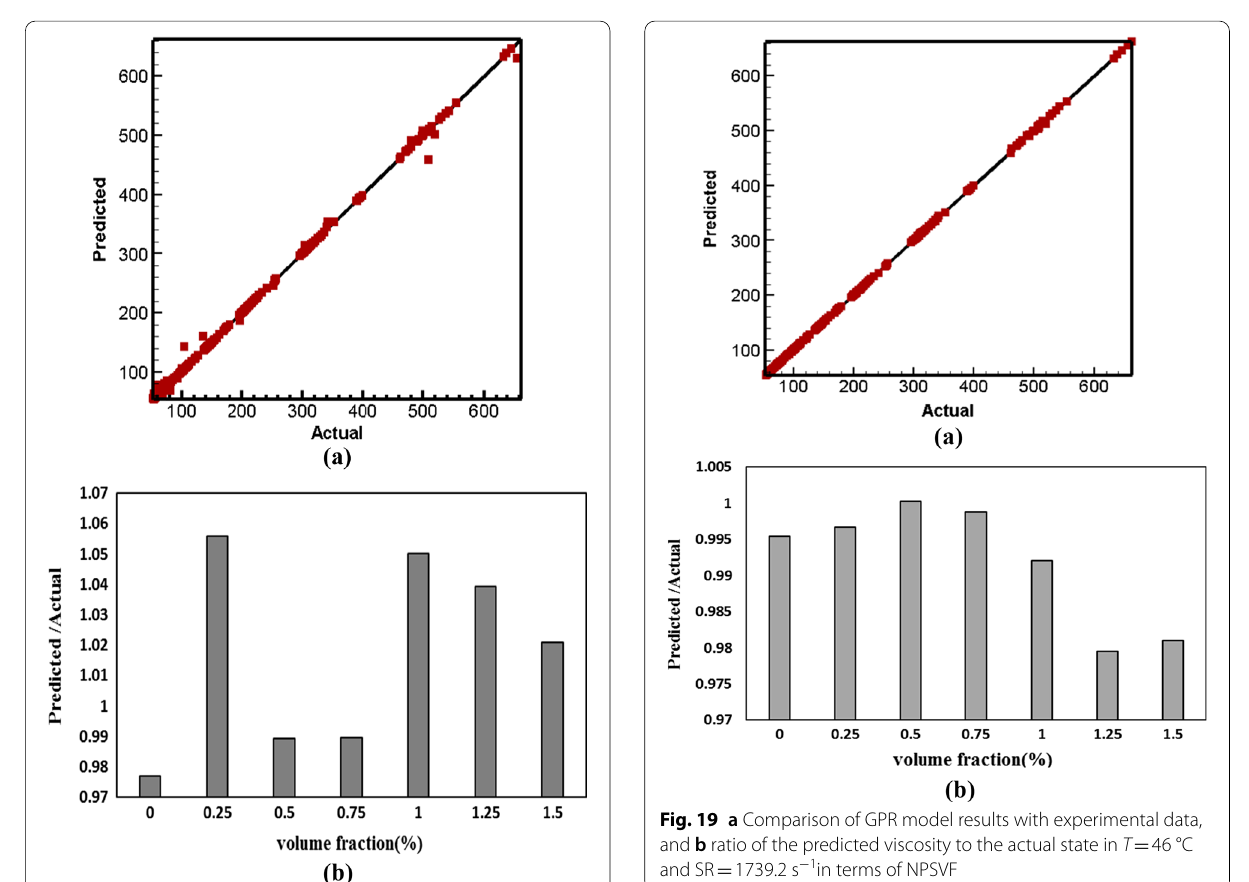
Fig. 17 a Comparison of ANFIS model with experimental data and b ratio of the predicted viscosity to the actual state in T SR 1739.2 s − 1 in terms of NPSVF =